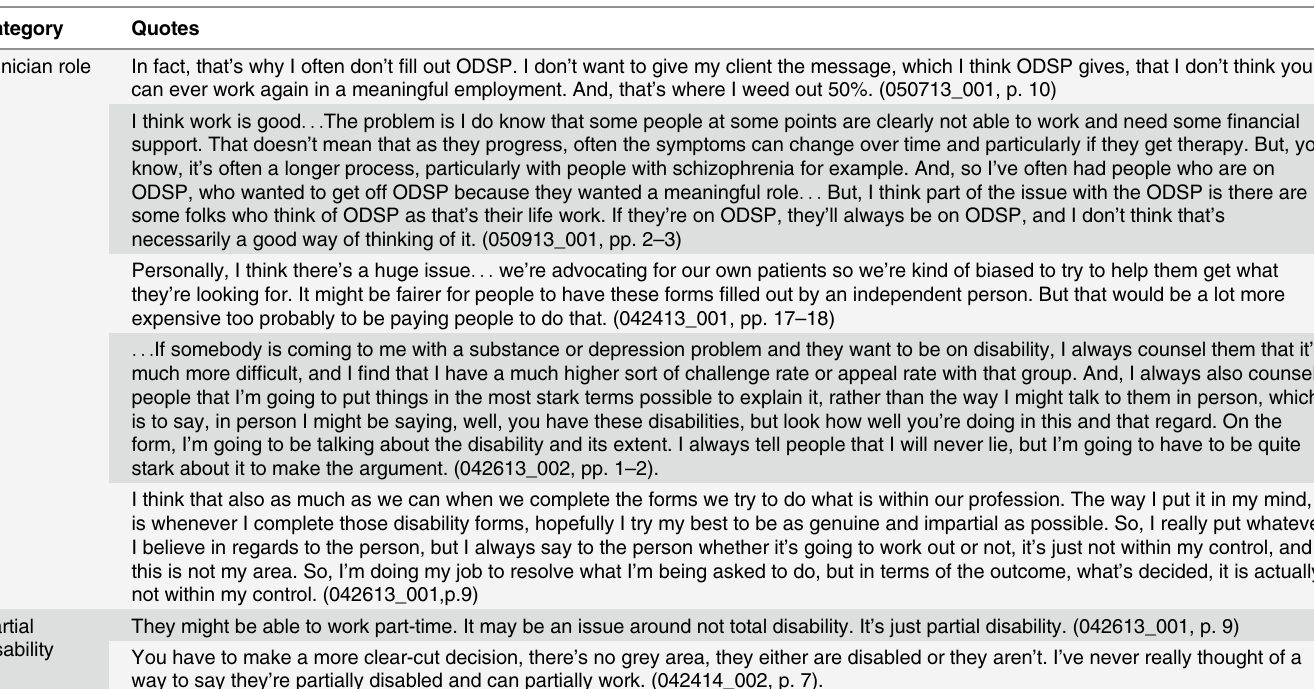
Table 3. Theme of Assessing Work Disability Categories and